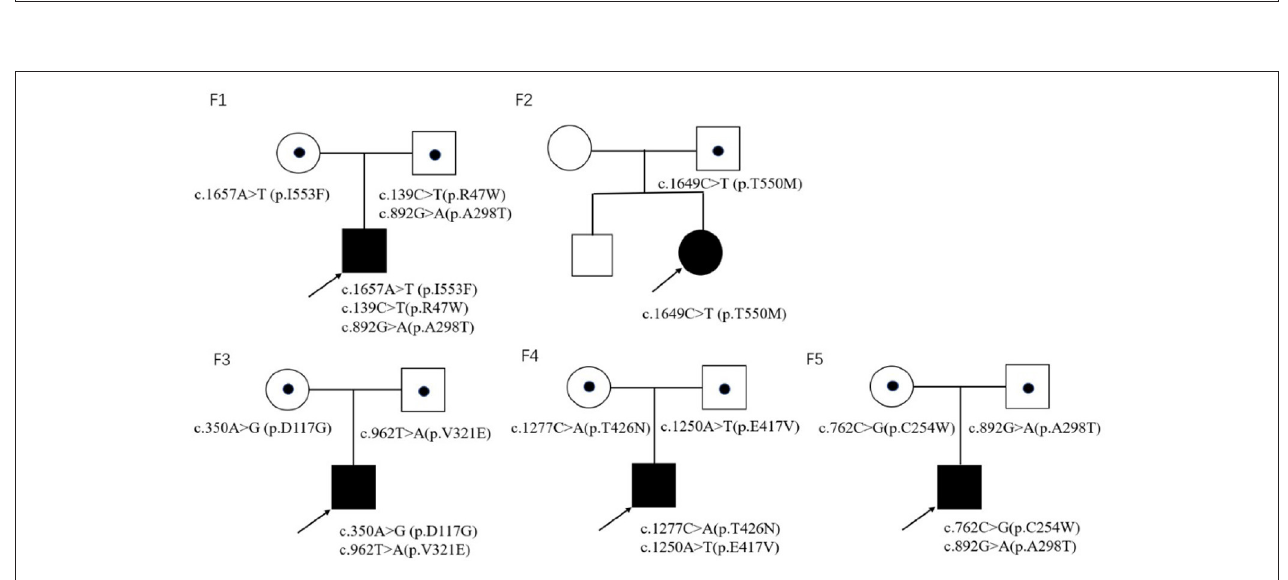
FIGURE 1 | Muscular pathological results of patient 2. No variation in fiber size, no classical degeneration, necrosis, or regeneration in H&E staining ( A , X200). No special hyperchromatic structures were observed in myofibrillar cytoplasm in MGT staining ( B , X200). No abnormal fiber structures observed in NADH staining ( C , X200). There were few angular muscle fibers in NSE staining ( D , X200).